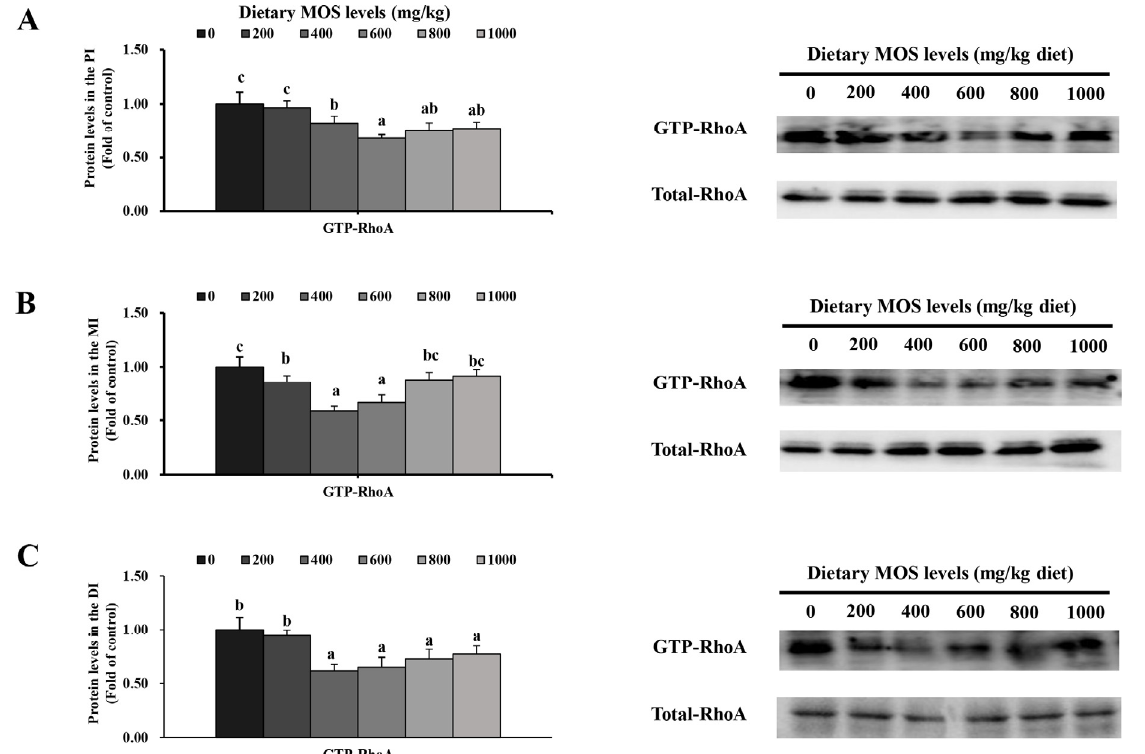
Figure 6. Western blot analysis of GTP-RhoA levels in the intestine of grass carp after infection with Aeromonas hydrophila . ( A ) Proximal intestine; ( B ) middle intestine; ( C ) distal intestine. Data represent means of three fish in each group, error bars indicate S.D. Values with different letters are significantly different ( p < 0.05). Quantification and analysis were performed through NIH Image J software (version 1.42 q , National Institutes of Health, Bethesda, MD,